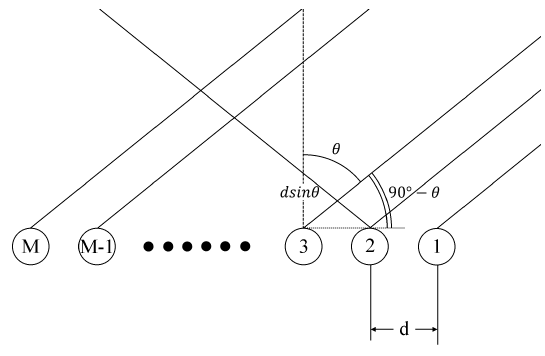
Figure 1. M -antenna ULA